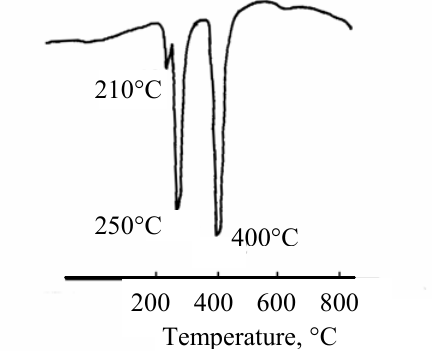
400°C °C200 800 400 600 Temperature, Figure 2 . DTA profile of ammonium heptamolybdate. Figure 2 . DTA profile of ammonium heptamolybdate.